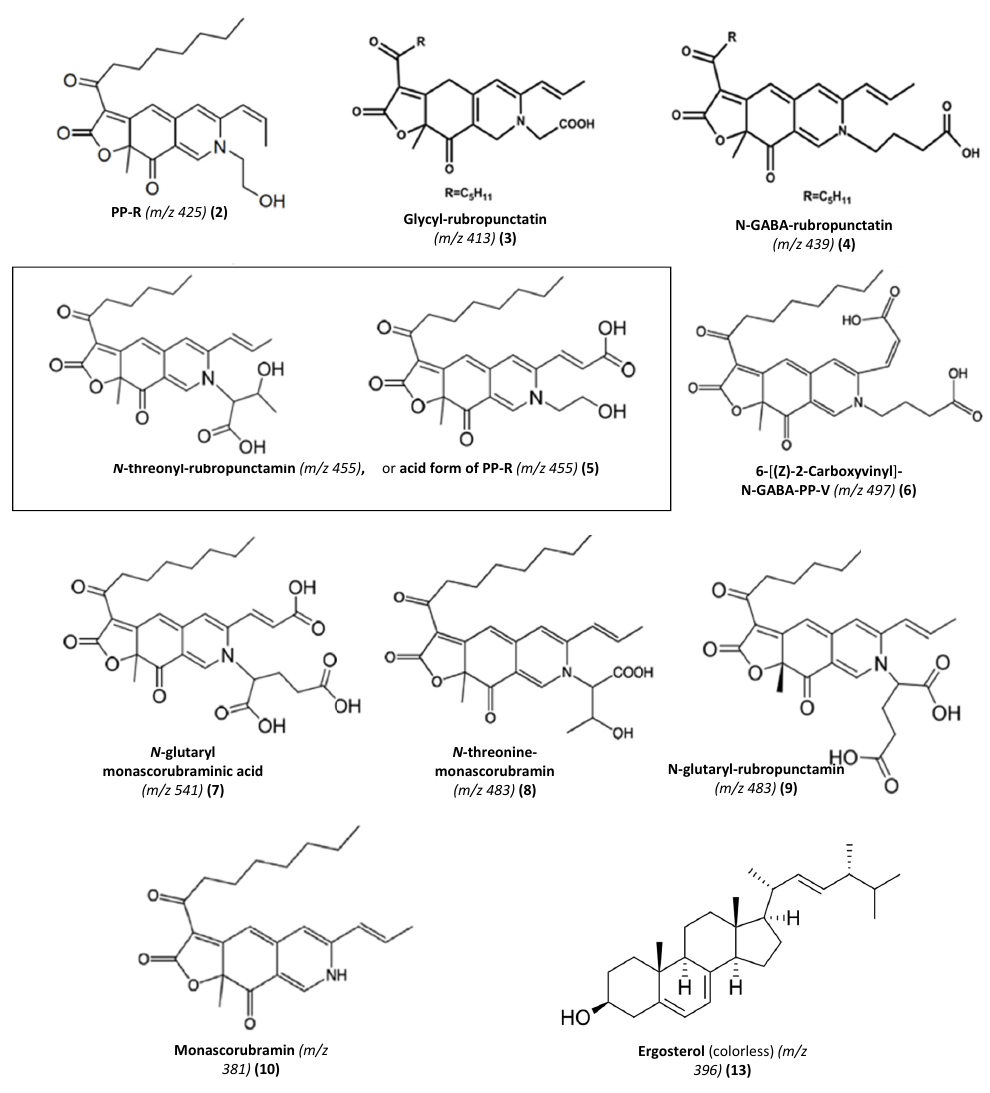
Figure 5. Main Monascus -like nitrogen-containing azaphilone pigments produced by the marine-derived Talaromyces sp. 30570 fungal strain. Assignment of the pigments ( 2 – 10 ) and ergosterol ( 13 ) were done by UV-visible spectra and HR-ESI-MS according to their mass to charge ratio. It is presumed that the major red pigment 5 produced by the fungal strain (see sidebar) might reasonably be the molecule N -threonyl-rubropunctamin (C 25 H 29 NO 7 , m / z 455) or the acid form (R-COOH) of the pigment PP-R (C 25 H 29 NO 7 , m / z 455) as recently reported by Rasmussen [30].